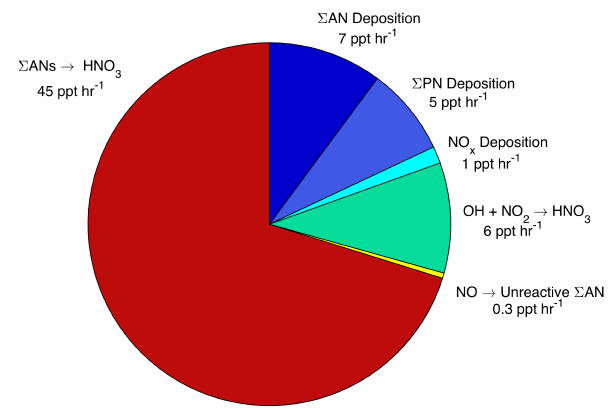
Figure 8. The average breakdown of NO SL loss between 10:00 and 14:00 during